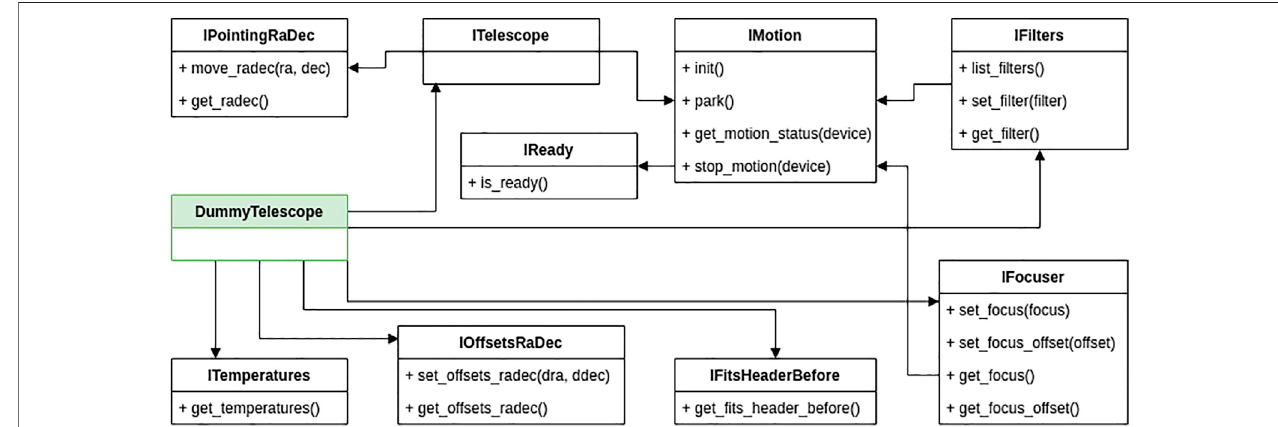
FIGURE 2 | Part of the interface inheritance for DummyTelescope (on the left in green), a simulated telescope that accepts RA/Dec coordinates and offsets and hasa fi lterwheel,afocusunit,andsometemperaturesensors.Allmethodsavailableforremotecallsarede fi nedintheinterfaces.ITelescopedoesnotde fi neanymethod of its own, but is just a collection of other interfaces and can be used as a device de fi nition, i.e., “ this is a telescope ”